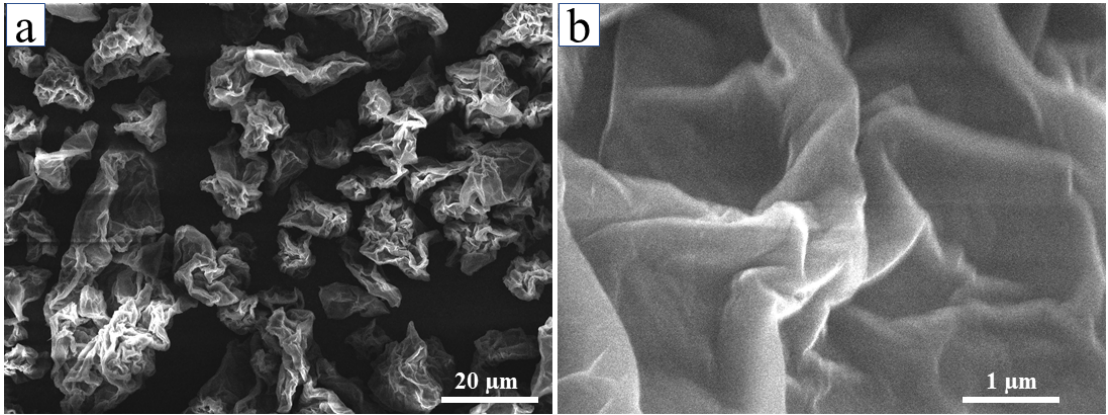
Figure 4. ( a ) General morphology of GO. ( b ) Magnification of single GO sheet.